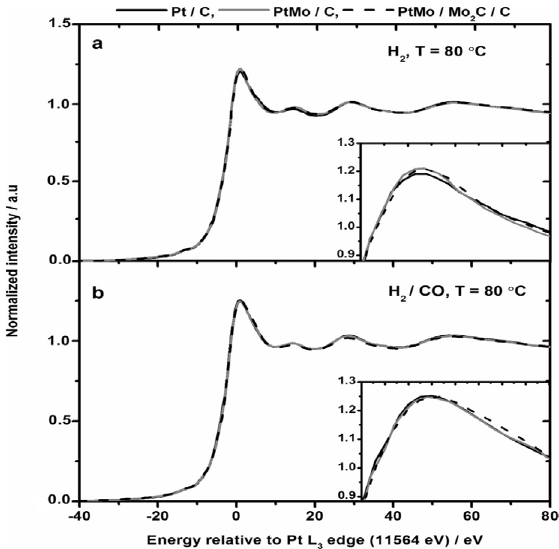
edge for carbon III and ( b ) H /CO. Cell temperature 2 2